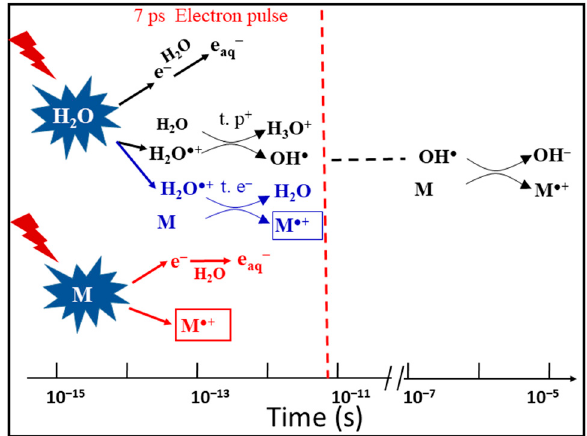
Figure 2. Schematic description of the reactions occurring in solutions containing a solute M at high concentration. At subpicosecond time scales involving proton transfer (t. p + , black), direct ionizing of solutes M (red), ultrafast electron transfer (t. e − , blue) and electron relaxation. Picosecond electron pulse radiolysis is ready to observe the formation of M • + within the pulse. The oxidation of M by OH • radical takes place at longer time, which does not affect our observation.